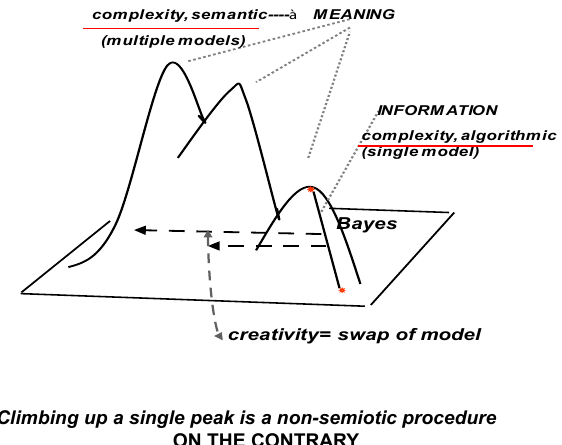
Figure 11. Recursive application of Bayes is equivalent to climbing a probability mountain, guided by the Model ,that is, the condition- al probability that an hypothesis generates a datum. This strategy is common e.g. to Darwin evolution and to Sherlock Holmes criminal investigation; since the algorithm is unique, it can be automatized in a computer program (expert system).